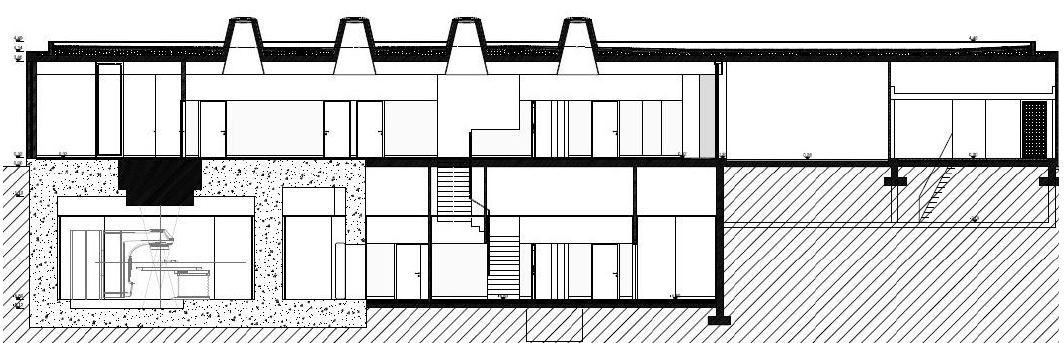
Figure 2. Architectural cross-cut (no scale).